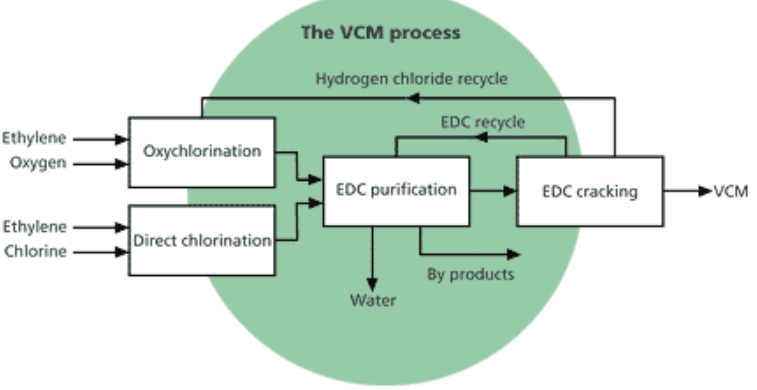
Figure 1 Schematic representation of the industrial production of VCM